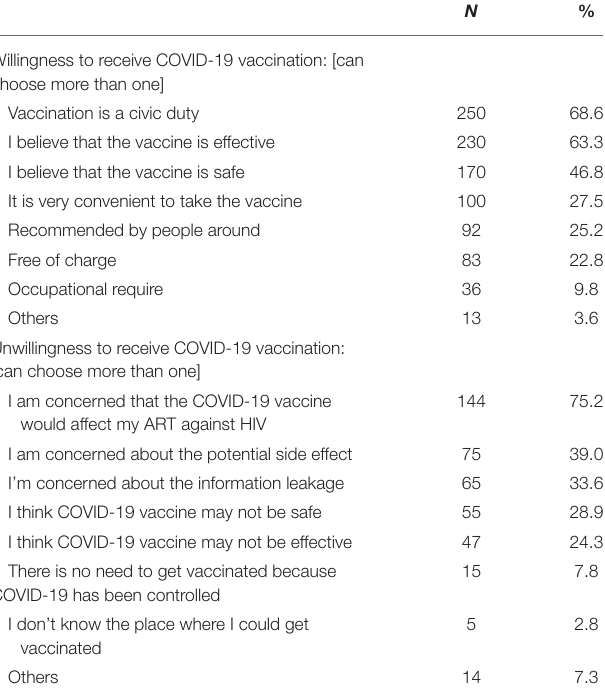
TABLE 3 | Reasons for willingness or unwillingness to receive COVID-19 vaccination among PLWH in Wuhan, China ( N = 556).